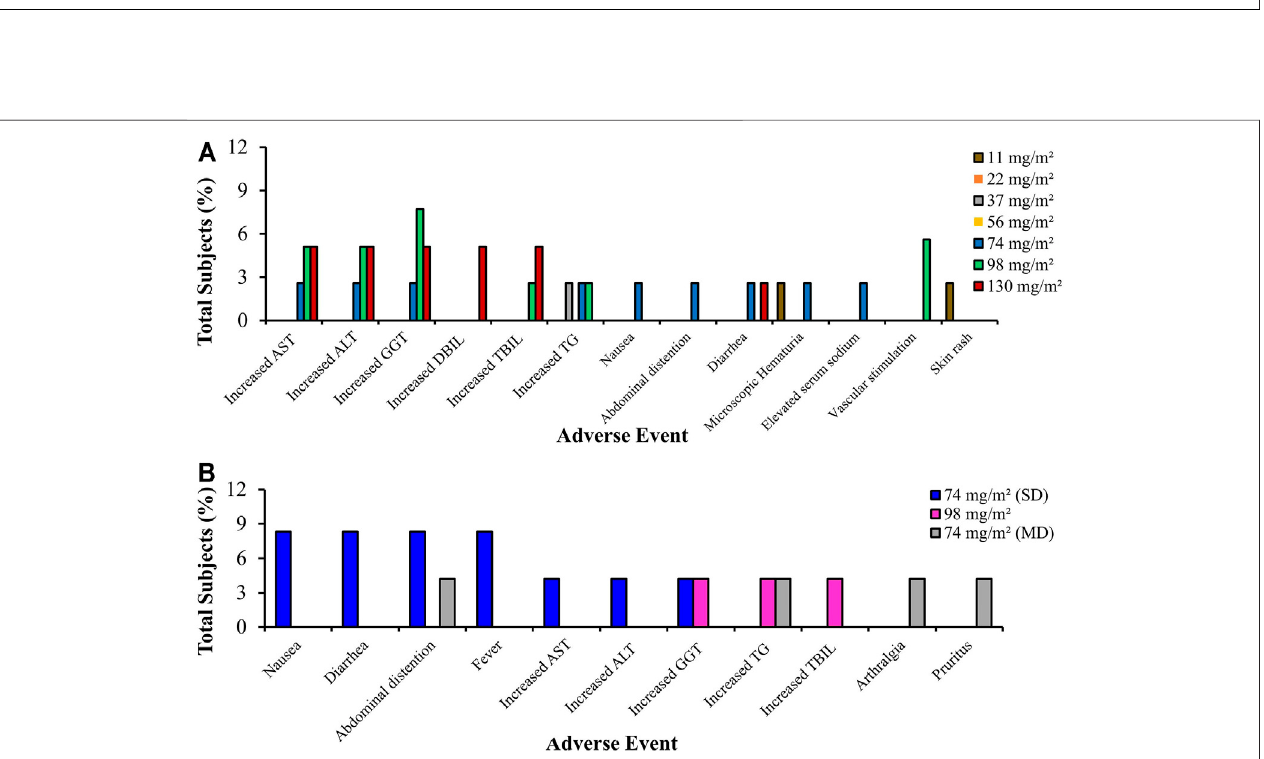
FIGURE 7 | Total subjects with adverse events of (A) Lipo B, and (B) Lipo C in phase I clinical trials. AST, AlanineAminotransferase/SGPT (serum glutamic pyruvic transaminase); ALT, Aspartate Aminotransferase/SGOT (serum glutamic oxaloacetic transaminase); GGT, Gamma Glutamyl Transpeptidase; DBIL, Direct Bilirubin; TBIL, Total Bilirubin; TG, Triglycerides